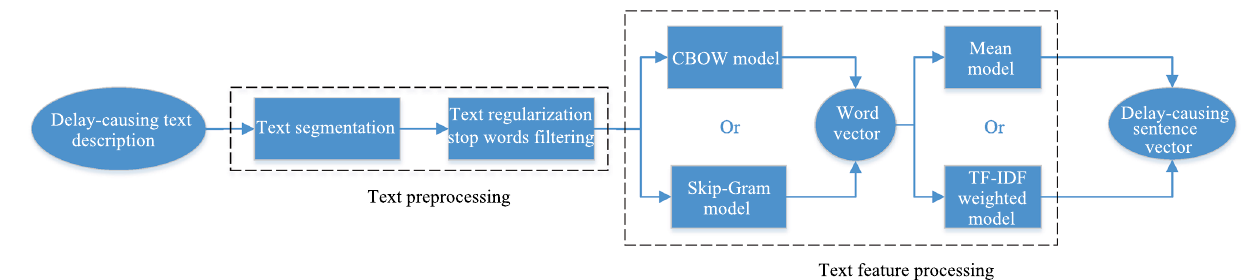
Fig. 6 Overall process of delay-causing text feature